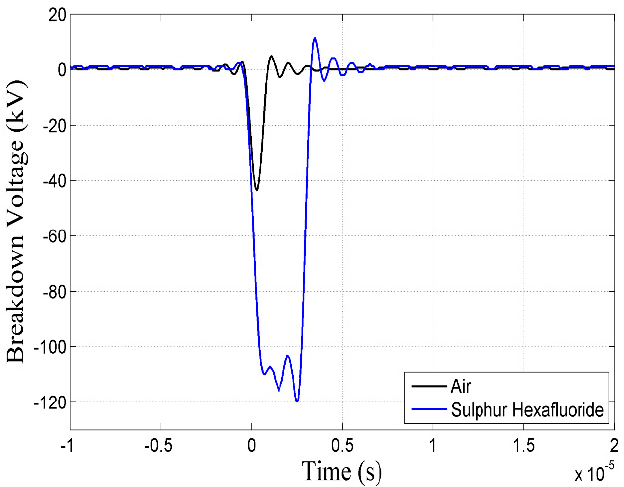
Figure 21. Lightning impulse discharge investigations regarding air and SF 6 for different FGIL models.